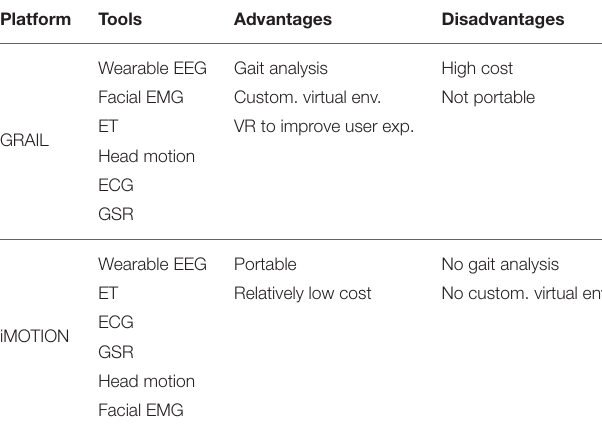
TABLE 5 | Advantages and disadvantages of modern platforms.